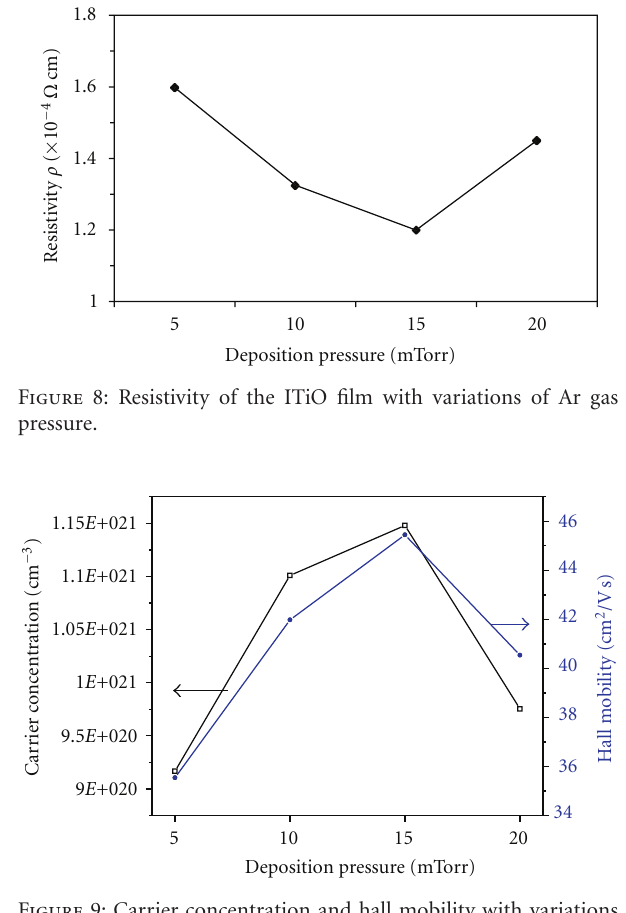
Figure 9: Carrier concentration and hall mobility with variations of Ar gas